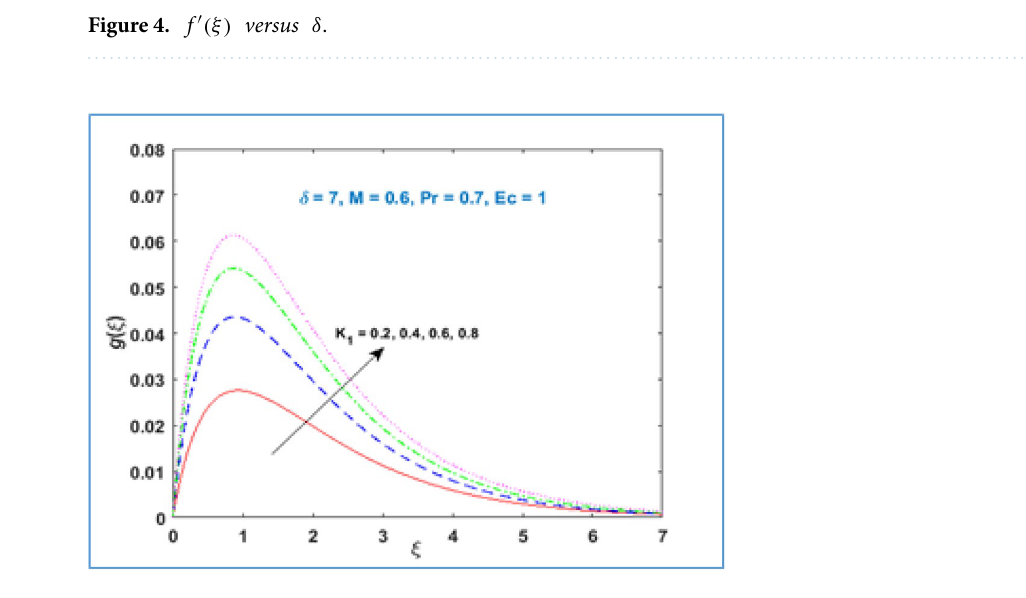
Figure 5. g (ξ) versus K 1 .